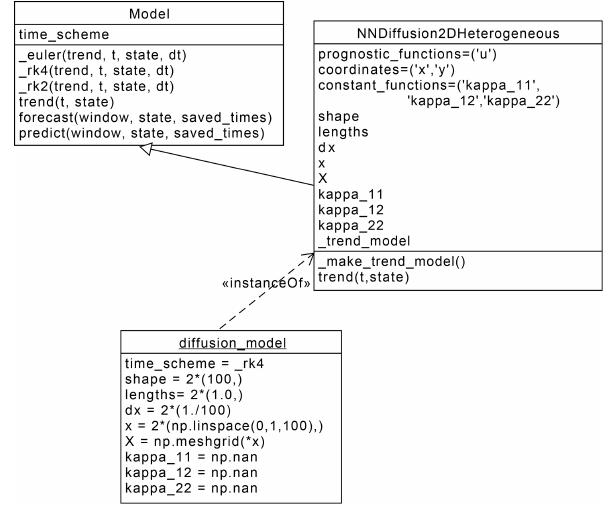
Figure 3. Unified modelling language (UML) class dia- gram showing the interaction between the Model and the NNDiffusion2DHeterogeneous classes, as well as the re- sulting instance diffusion_model corresponding to the numer- ical computation of the diffusion equation (Eq.